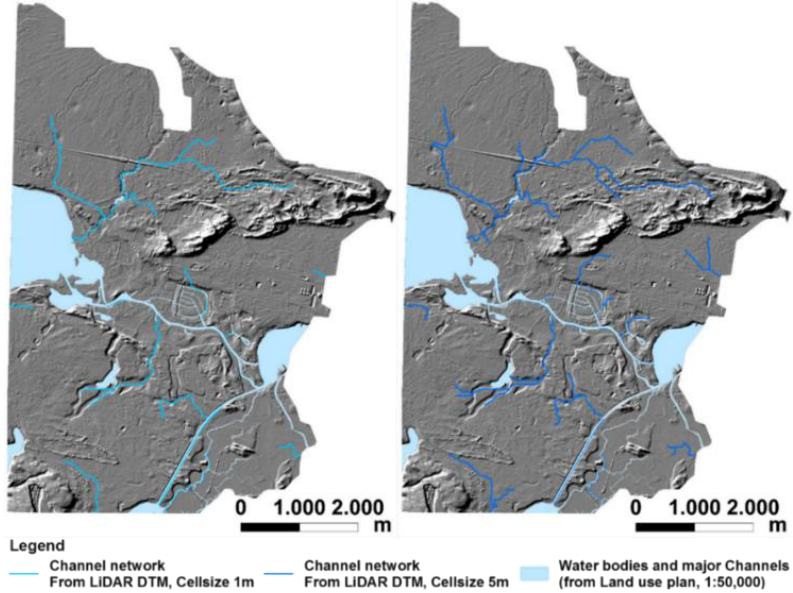
Figure 5. Comparison of flow major channel networks derived from LiDAR-DEM, cell size of 1 m ( left ) and of resampled 5 m ( right ).